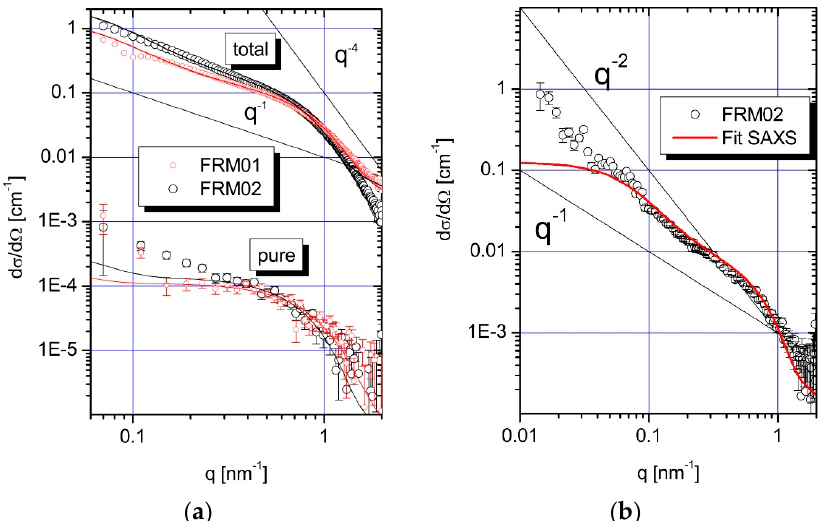
Figure 1. ( a ) SAXS curves of samples FRM01 and FRM02 measured at three different X-ray energies in the vicinity of the LIII-absorption edge of Pb at 13,035 eV. The curves with the label “total” represent the total scattering, while the curves with label “pure” represent the form factor of the pure-resonant contribution. Note that the separated form factor of the pure-resonant scattering contribution is more than three orders of magnitude smaller with a cross-section down towards 10 –5 cm − 1 (!) when compared to the total scattering (factor 2000); ( b ) SANS curve of the sample FRM02. The solid lines running through the symbols of the scattering curves are fitted their respective scaled model functions representing the “freely jointed chain pearl necklace” FJC-PN model (see text).